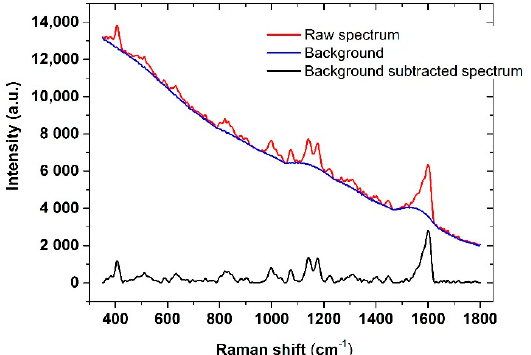
Figure 2. SERS spectrum of the functionalized substrate: Raw spectrum with fluorescence background (red line), fluorescence background (blue line), background-subtracted spectrum (black line).